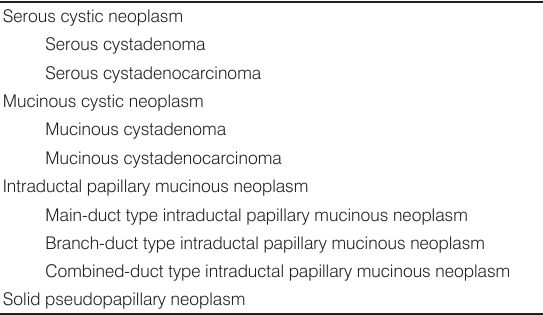
Table 3. Classification of pancreatic cystic